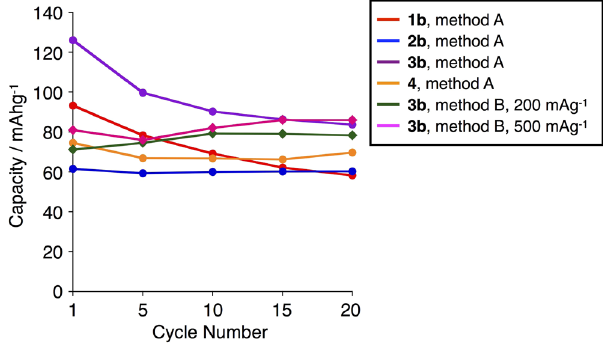
Figure 7. Cycle performance of discharged capacities at 2.5 V ( 1b - 3b ) or 2.0 V ( 4